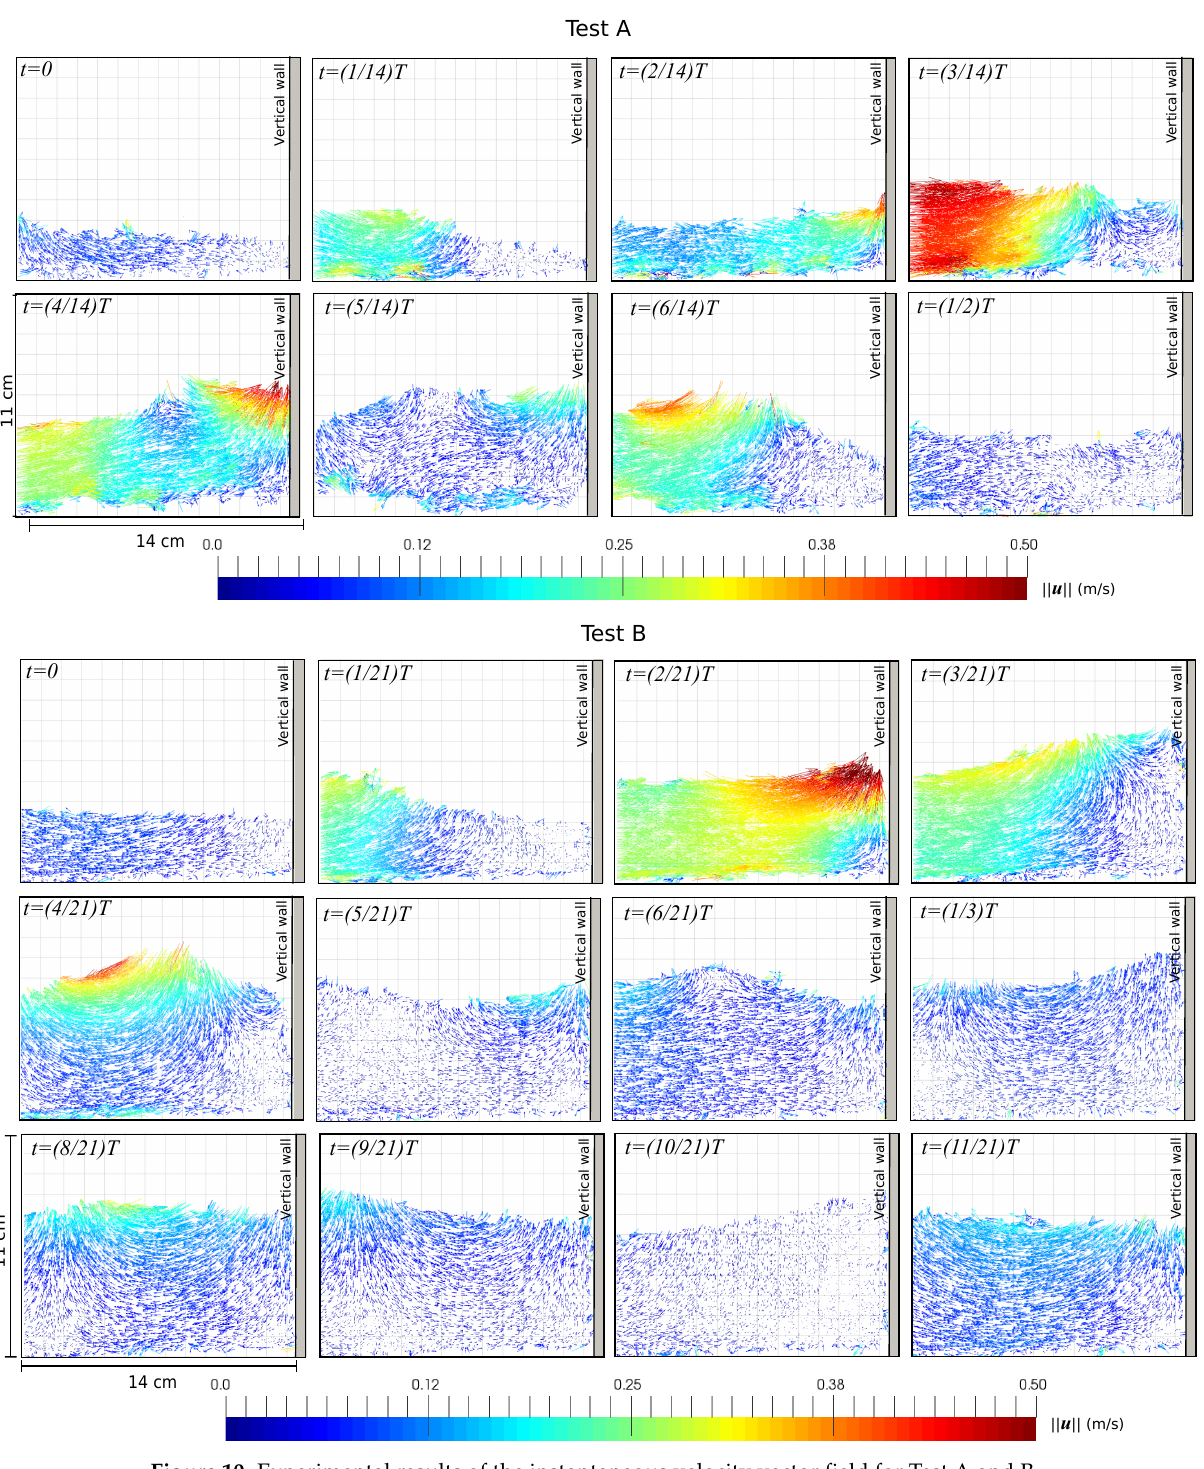
Figure 10. Experimental results of the instantaneous velocity vector field for Test A and